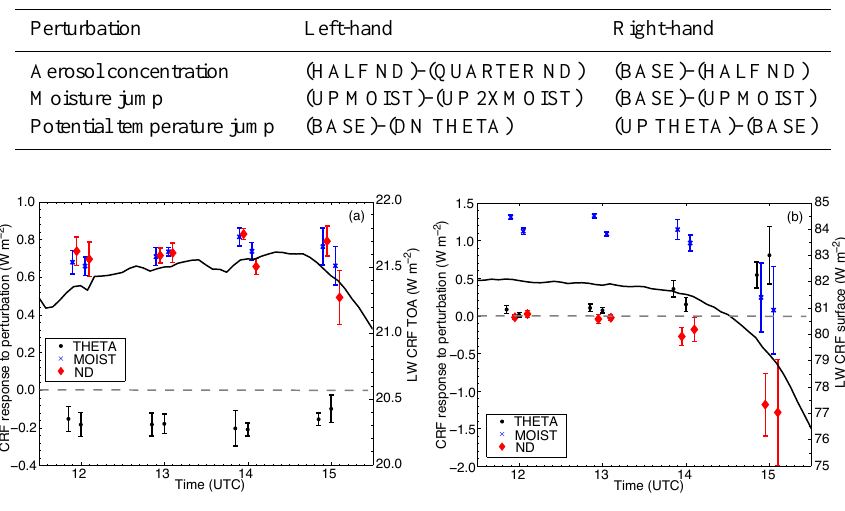
Fig. 12. Response of longwave cloud radiative forcing (LW CRF), at (a) TOA and (b) the surface to perturbations in meteorological context and aerosol state, computed from the experimental simulations (left y-axis). Responses of LW CRF are shown are shown as described in Fig. 11. For reference the black line shows the time series of base case LW CRF (right y-axis) and the grey dashed line indicates a zero response in LW